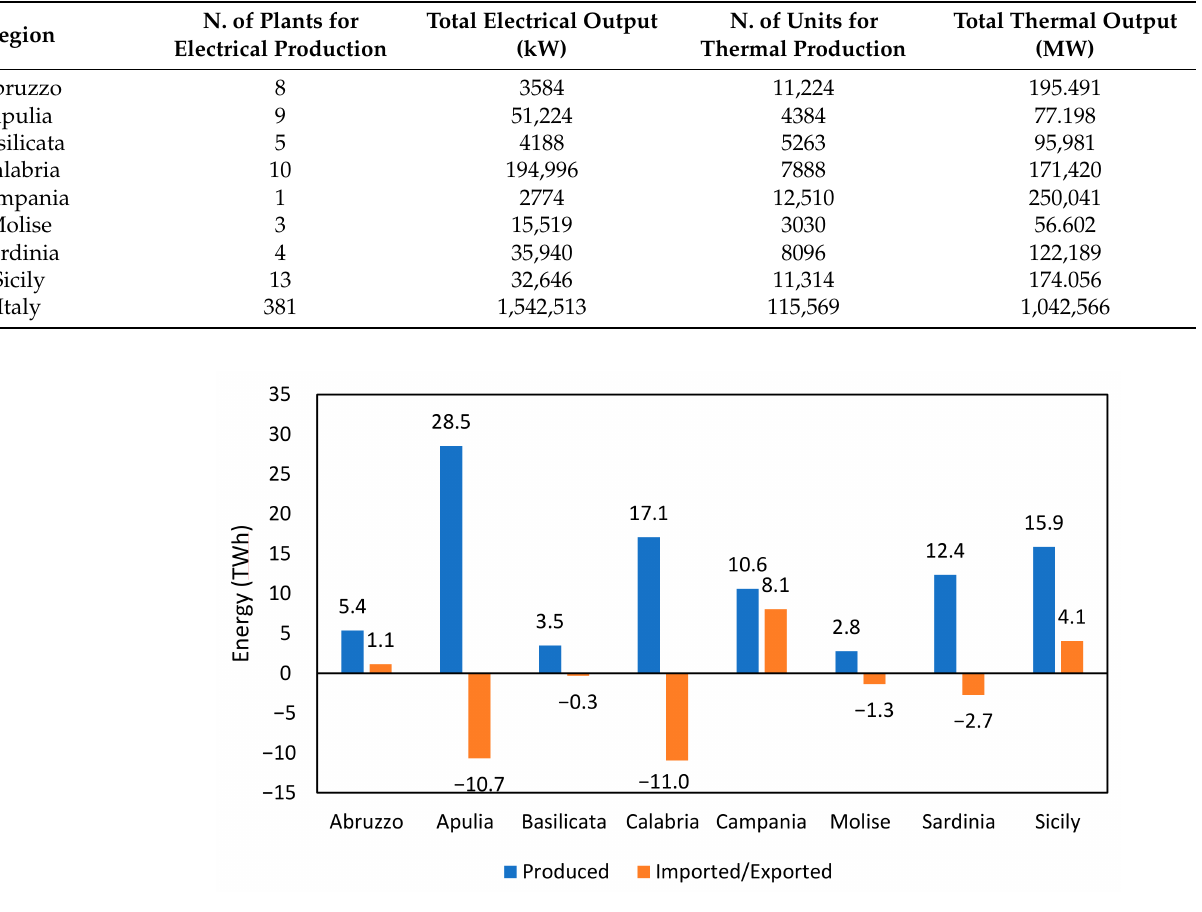
Figure 3. Production and import or export of electricity in Southern Italy (data adapted from [54] by Terna spa,